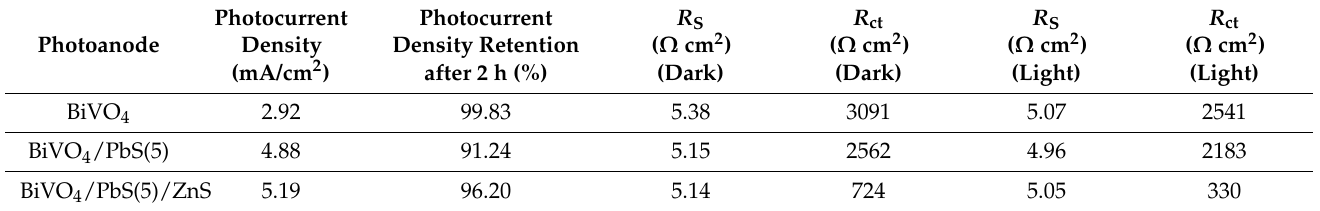
Figure 7. ( a ) J-V curves and ( b ) chronoamperometric curves (at 1.23 V RHE ) of bare BiVO 4 , BiVO 4 /PbS(n) QDs, and BiVO 4 /PbS(5) QDs/ZnS photoanodes (n: the number of PbS SILAR cycles). Table 1. Summary of J-V, chronoamperometric properties, and EIS parameters for bare BiVO 4 , BiVO 4 /PbS(5), and BiVO 4 /PbS(5)/ZnS photoanodes. All data were achieved at 1.23 V RHE .